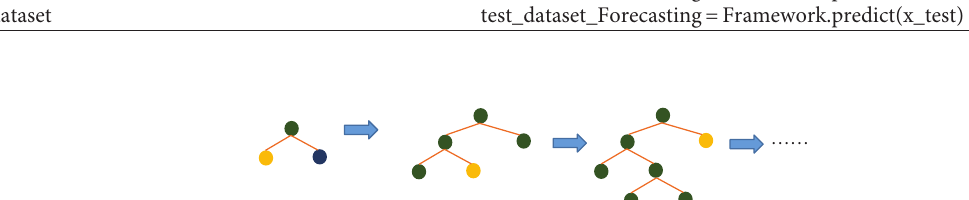
Figure 7: Description of LightGBM employed in this study.